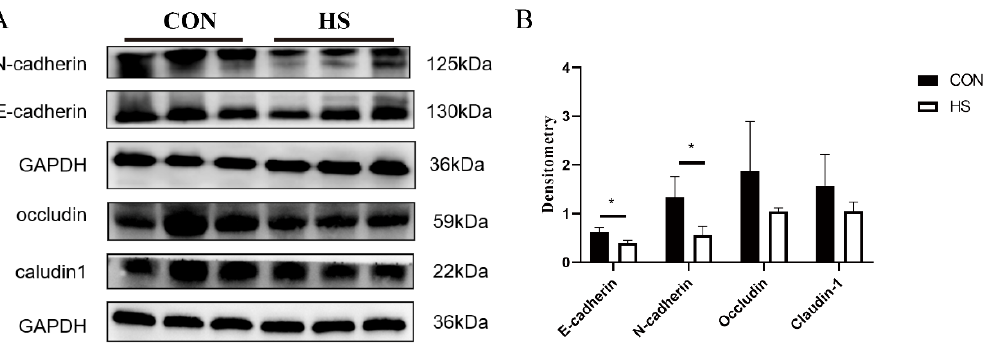
Figure 2. ( A ) Western blot analysis of effects of heat stress on expression levels of E-cadherin, N- cadherin, occludin, and claudin-1 proteins. ( B ) Densitometry analysis of proteins related to epithelial cell integrity. * p < 0.05.